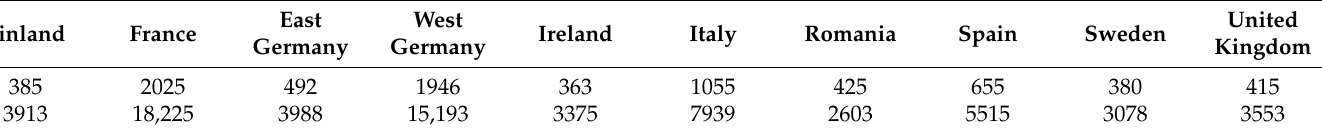
Table 1. Structure of the data set. Source: FADN database and authors’ own